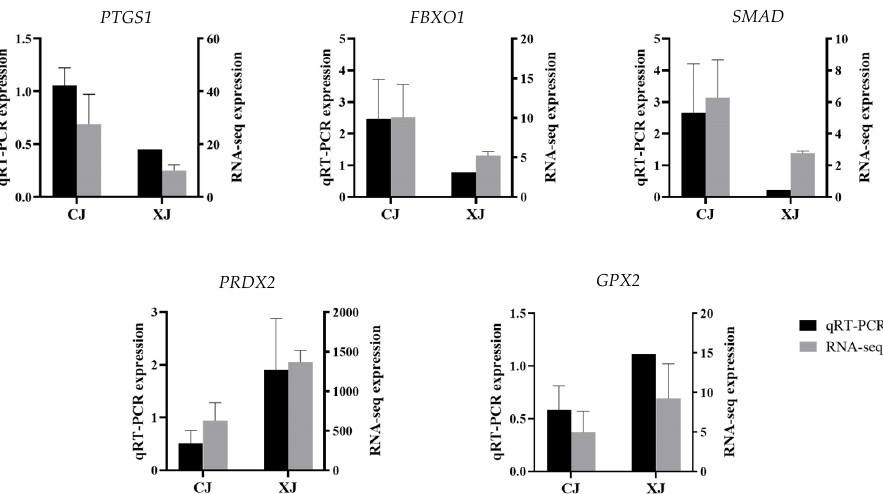
Figure 3. Quantitative real-time PCR for validation of RNA-seq. qRT-PCR verification of five differ- entially expressed genes in CJ vs. XJ. The left vertical axis represents qRT-PCR relative expression. The right vertical axis represents RNA-seq expression. PTGS1 , prostaglandin-endoperoxide syn- thase 1; FBXO11 , F-box protein 11; SMAD4 , SMAD family member 4; PRDX2 , peroxiredoxin 2; GPX2 , glutathione peroxidase 2.